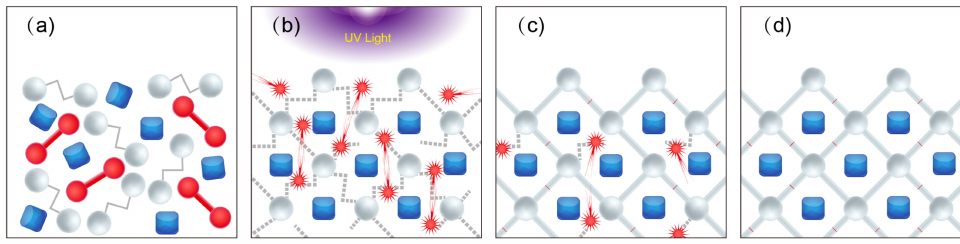
Figure 2. ( a ) Schematic representation of UV ink, being jetted onto a substrate; pigment particles (blue), photoinitiator (red) and monomers and oligomers (gray). ( b ) The UV light degrades the photoinitiator into free radicals, which chemically react with the monomers and oligomers; ( c ) photopolymerization continues until all monomers and oligomers have reacted; and ( d ) solidified UV-curable ink with captured pigment